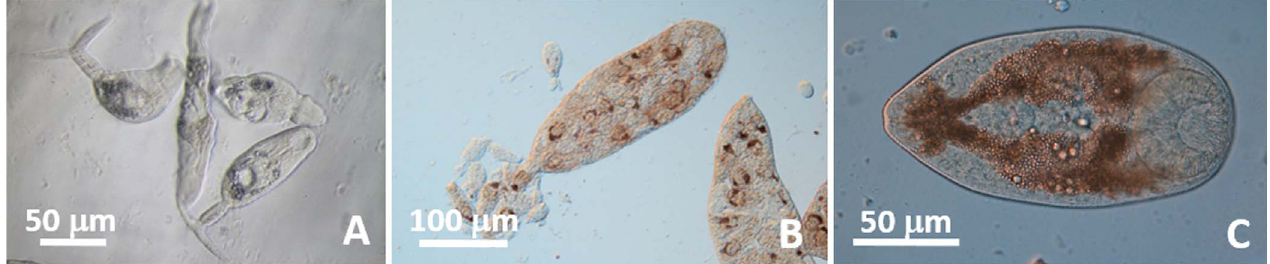
Figure 5. Parvatrema cf. donacis life stages in coquina Donax spp. (A) Unstained, live furcocercous, distome cercariae in D. fossor . (B) Unstained, live sporocysts with terminal birth pore in D. fossor . (C) Unstained, live metacercaria from mantle of D. variabilis